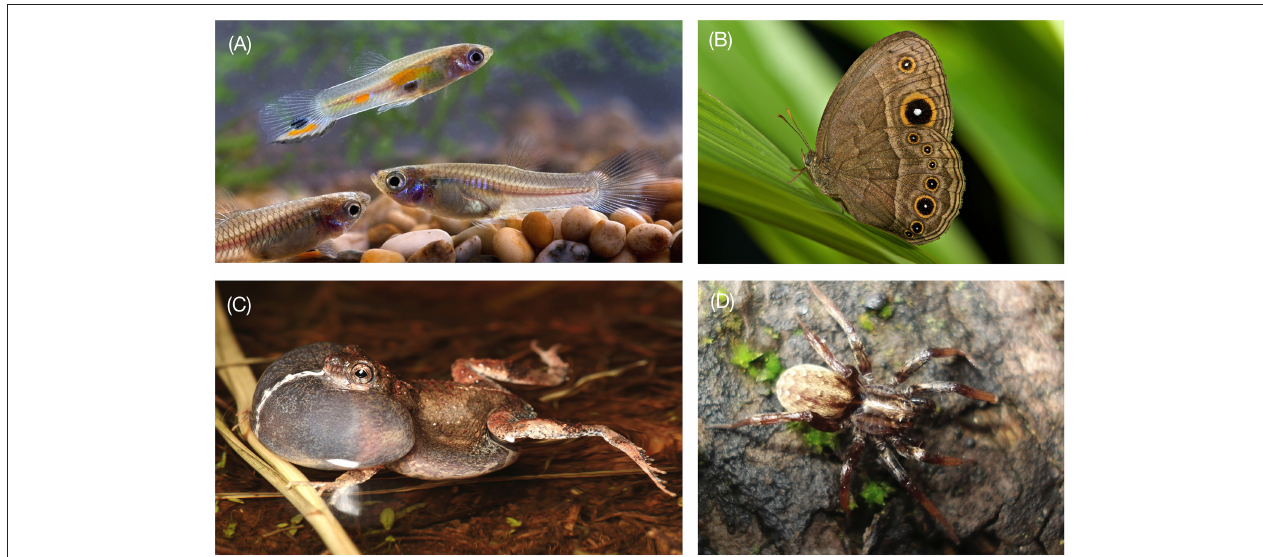
FIGURE 1 | Examples of organisms whose signals are under the influence of both sexual and natural selection. (A) Trinidadian guppy, Poecilia reticulata . Females prefer signals that are also an easier target for predators; (B) Squinting Bush-brown, Bicyclus anynana . The eyespot markings on the ventral side of their wings deter predators, while dorsal markings signal to potential mates; (C) Túngara frog, Engystomops pustulosus. Females prefer signals of higher complexity, which are also easier to detect by predators such as bats; and (D) Wolf spider Hygrolycosa rubrofasciata . Males vibrate their abdomen against the dry leaf substrate producing a drumming that is even audible for humans. Females prefer males with a high drumming rate, yet a high drumming rate can lead to increased predation risk. Photos: (A) PH Olsen CC BY 3.0, Wikimedia Commons; (B) Oskar Brattström; (C) R. Taylor; (D) Sanja565658 CC BY-SA 3.0, Wikimedia